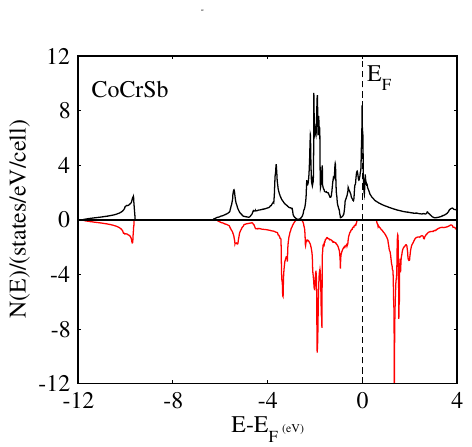
Figure 5. Calculated total spin density of states (DOS) of Type-I CoYSb